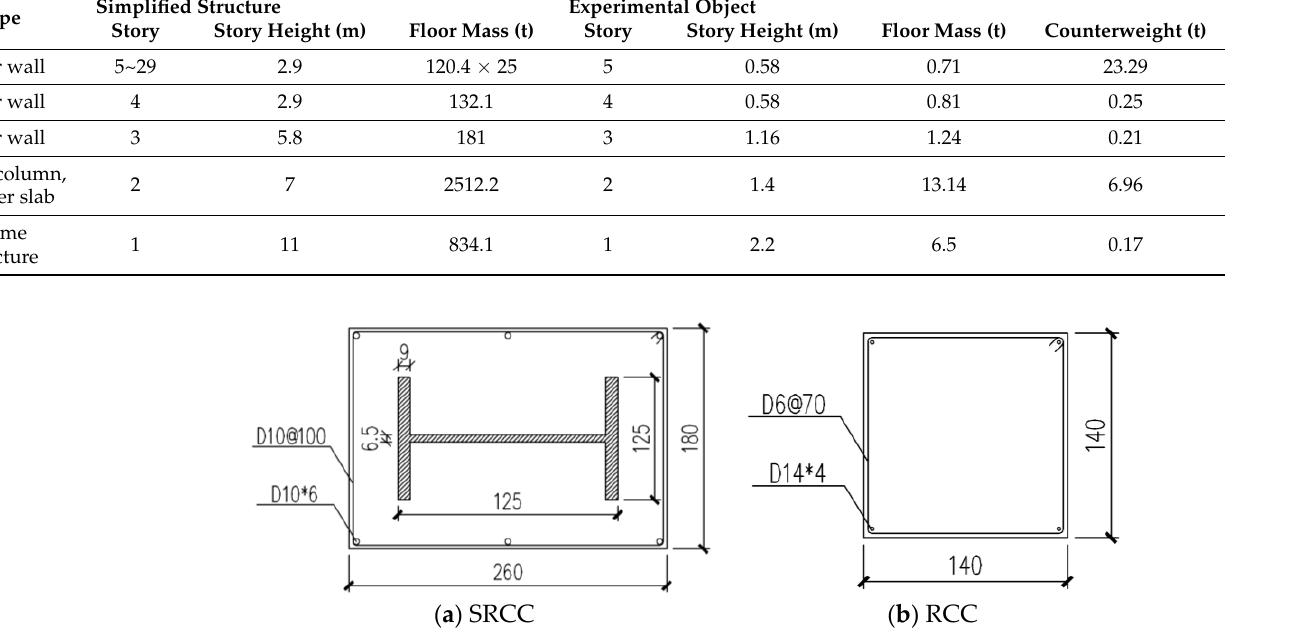
Table 1. Story height and additional weight.